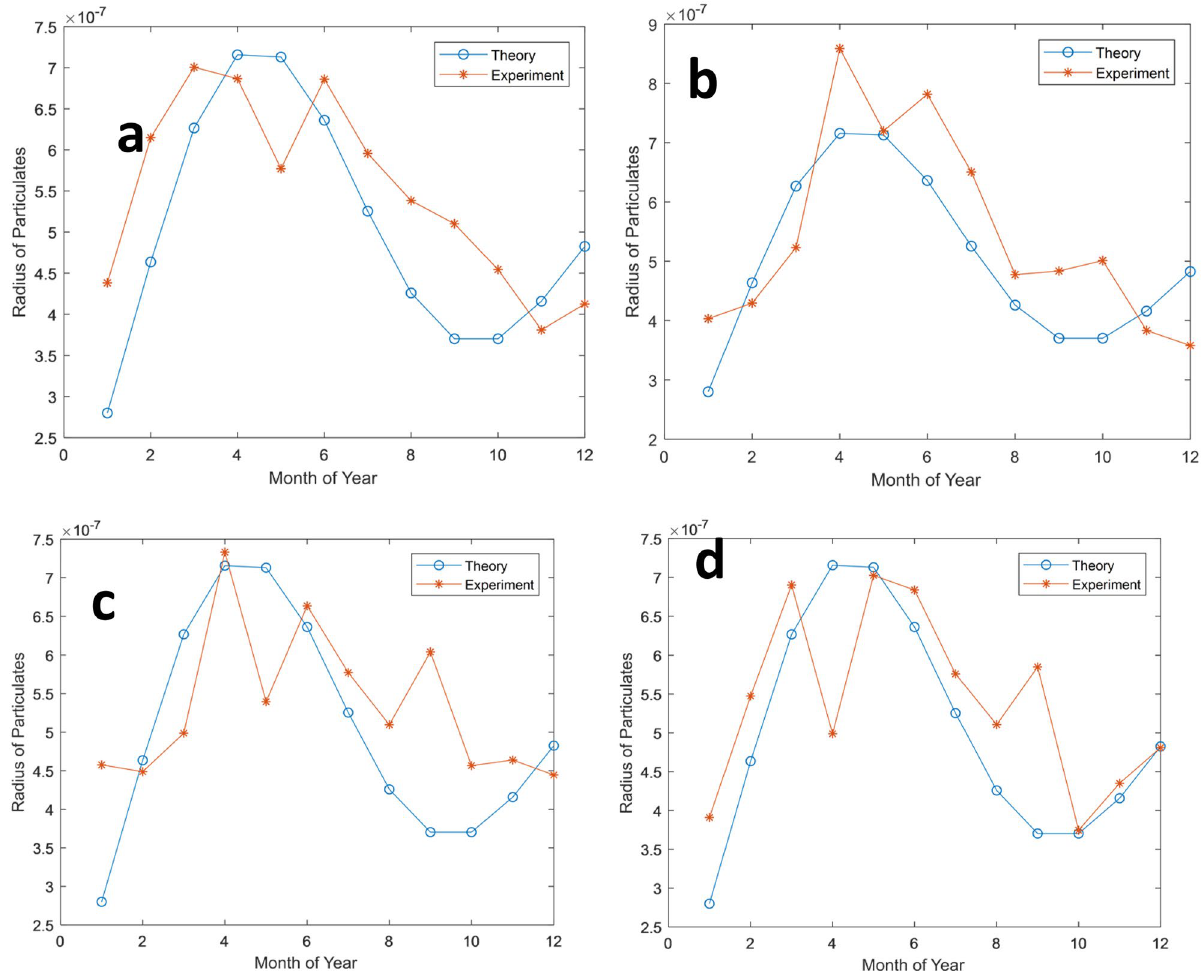
Figure 11. Dust deposition model in human